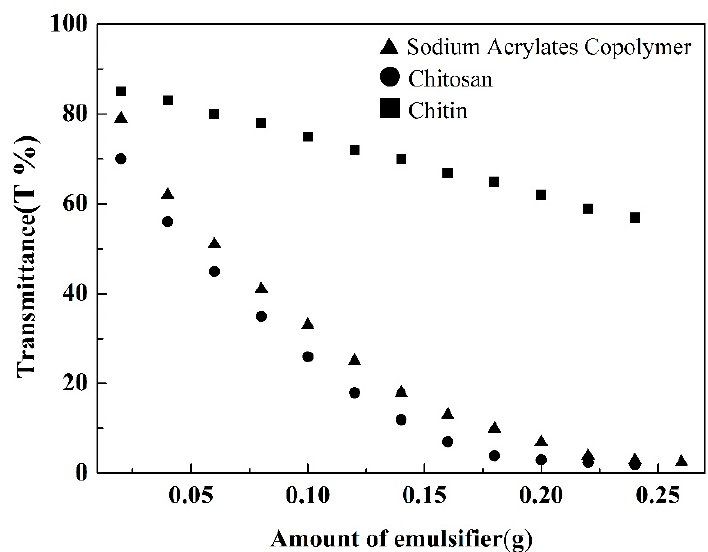
Figure 5. Change of transmittance with amount of emulsifier.